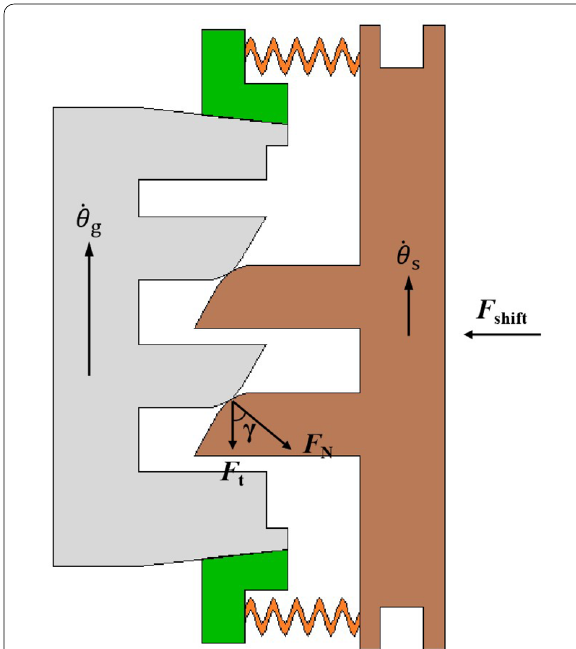
Figure 17 Schematic diagram of the structure of using the speed difference generated by the turn-teeth to complete the